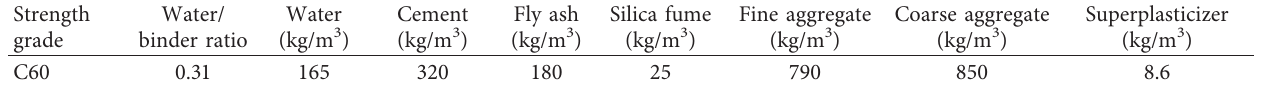
Table 1: Mix proportions of massive self-compacting concrete pumped in steel tube columns.